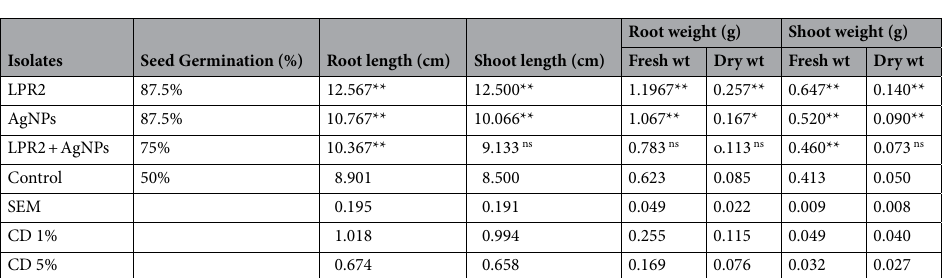
Table 2. Effect of Bacillus cereus LPR2 and silver nanoparticles on seed germination and growth parameters of Zea mays . SEM= standard error mean; CD= Critical Difference, Values are mean of 3 randomly selected plants from each set, ** significant 1%, * significant at 5% as compared to control, ns= non-significant as compared to control, Control (Non-bacterized seeds).